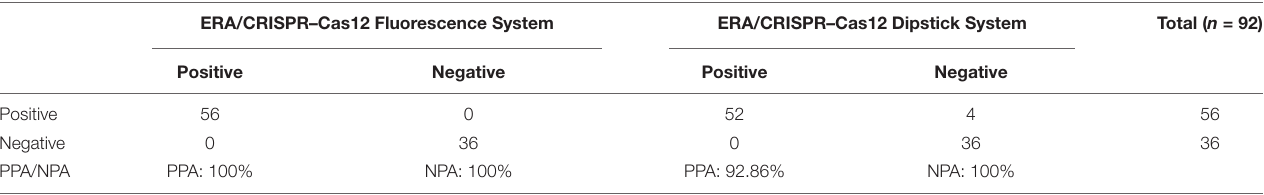
TABLE 3 | Comparison between the performance of the ERA/CRISPR–Cas12a dual system and commercial qPCR